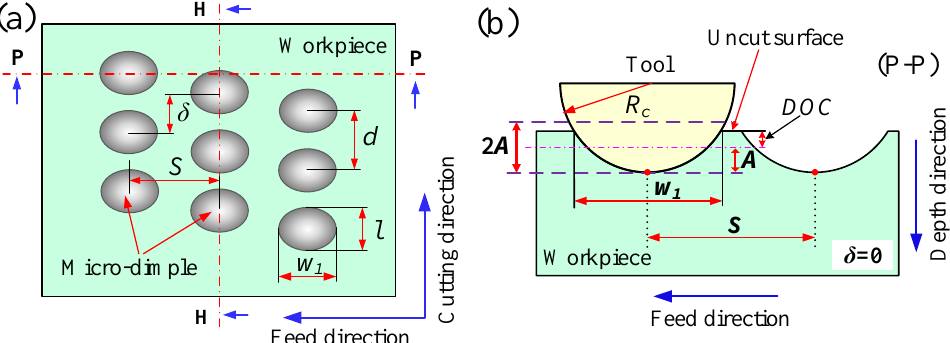
Figure 2. Illustration of micro-textured surface, generated under intermittent cutting conditions: ( a ) arrangement and geometry of micro-dimples; ( b ) the cross-sectional dimple profile along the feed direction.